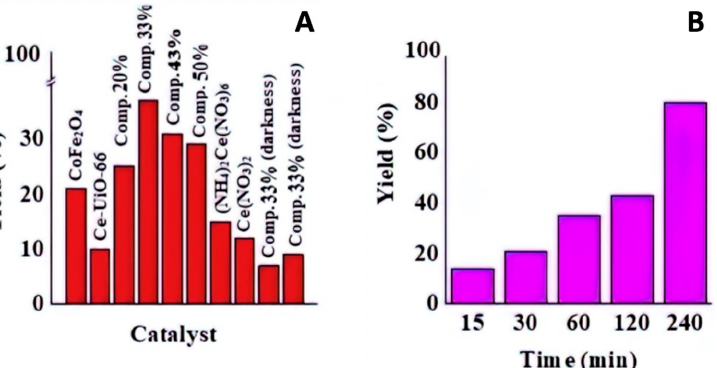
Figure 14. Graphs of n -hexane oxidation yield vs.: ( A ) applied catalyst ( B ) reaction time (Reprinted with permission [166]. Copyright 2021 Elsevier).